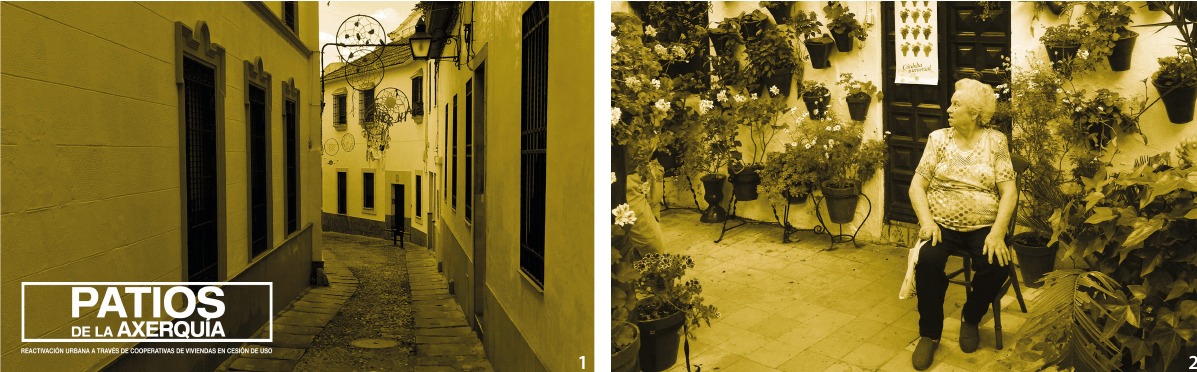
Figure 1 A typical street of Axerquia and PAX logo (Source: PAX). Figure 2 A typical patio house of the Axerquia with an old woman living alone (Source: Carlos